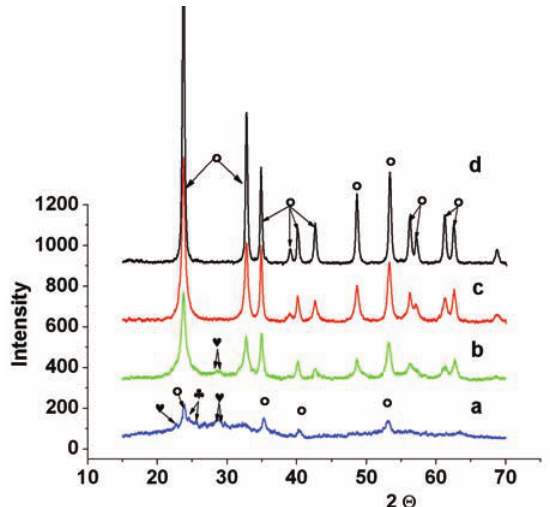
Fig. 4 Diffraction patterns of mechanically activated mixture a) − 10 minutes, 0.1 CuO and the products of its thermal treatment at